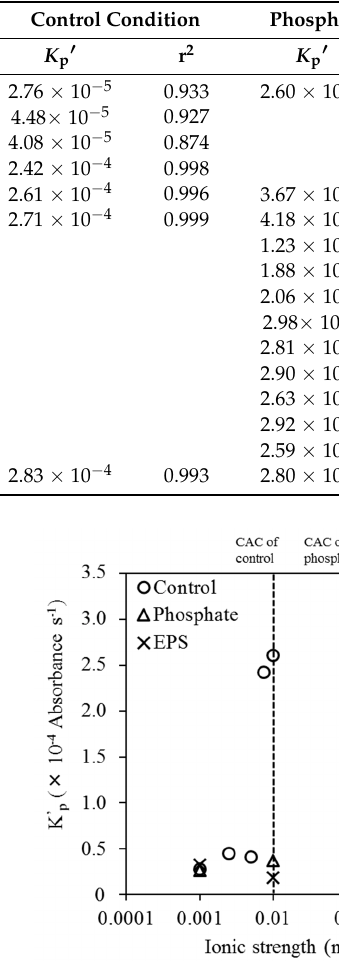
Table 6. Summary of the aggregation rates calculated based on the slope of Equation (2).